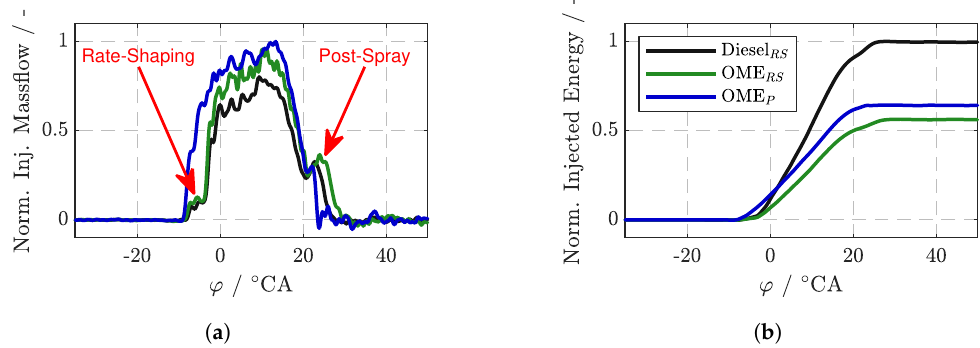
Figure 2. Example of normalized injection rate ( a ) and normalized injected energy ( b ) for RS − and P − nozzle at n = 2640 1/min, TOE = 1950 µ s and SOE = 26.5 ◦ CA